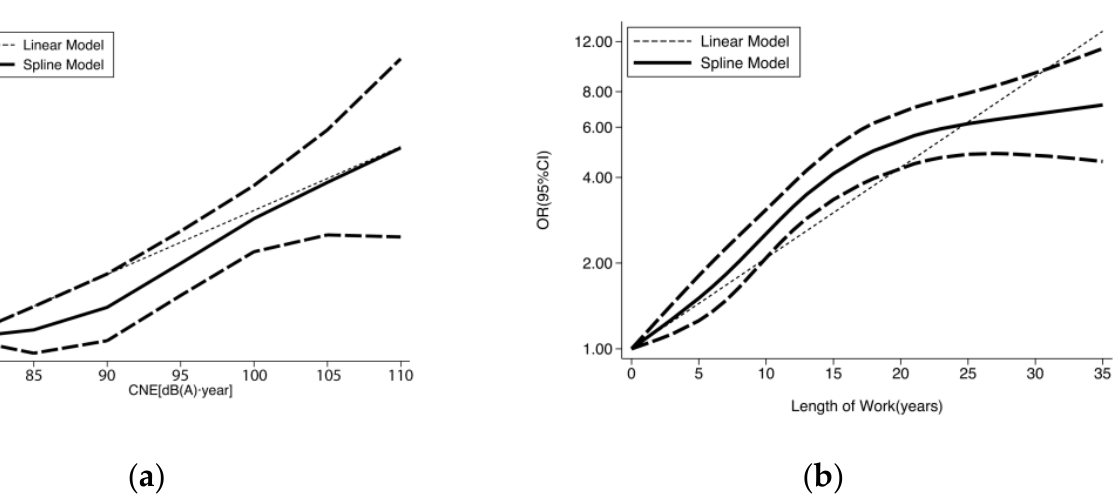
Figure 3. ( a ) Dose – response relationships between CNE and HFNIHL; ( b ) Dose – response relation- ships between length of work and HFNIHL. Table 4. Gender, age, length of work, cumulative noise exposure and risk of HFNIHL.